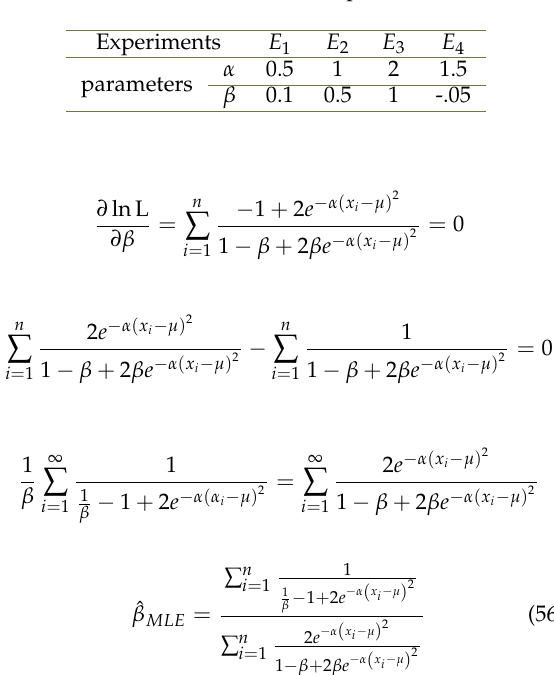
Table 1. Defult value for